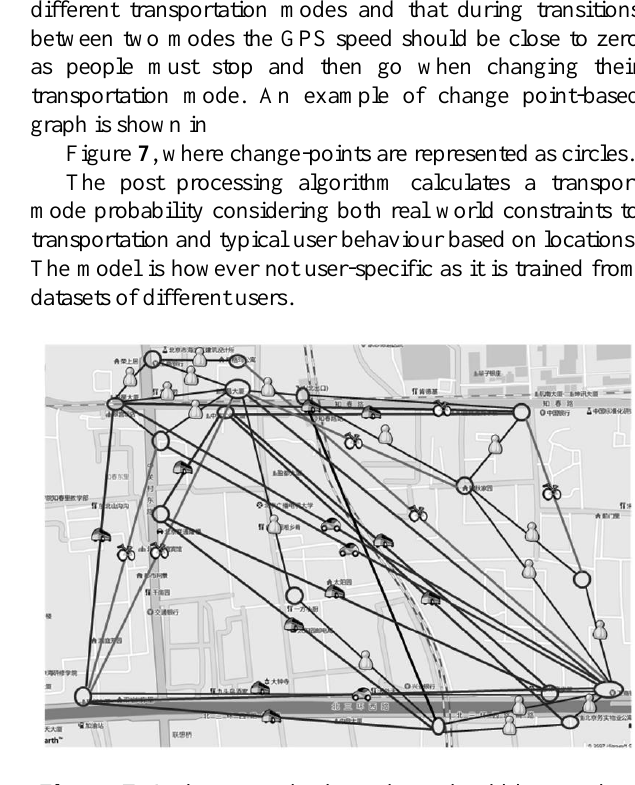
Figure 7 . A change point-based graph within a region